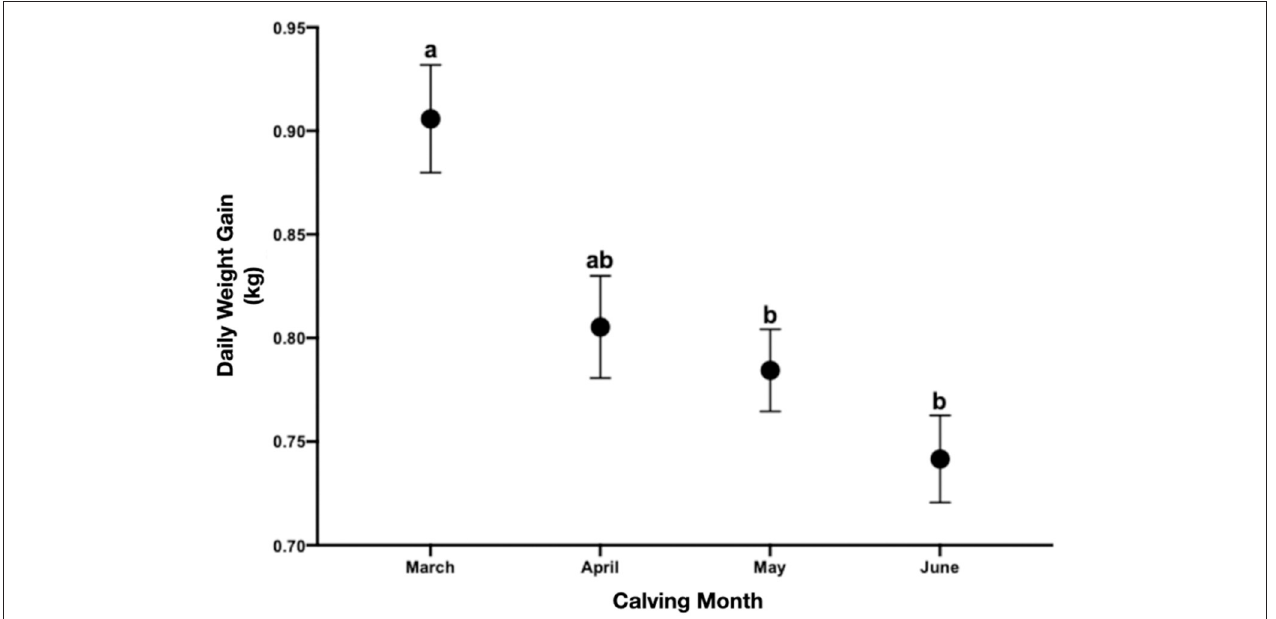
FIGURE 5 | Daily weight gain of the calves at 160 days postpartum for every calving month. Different letters between months are statistically significant ( P <